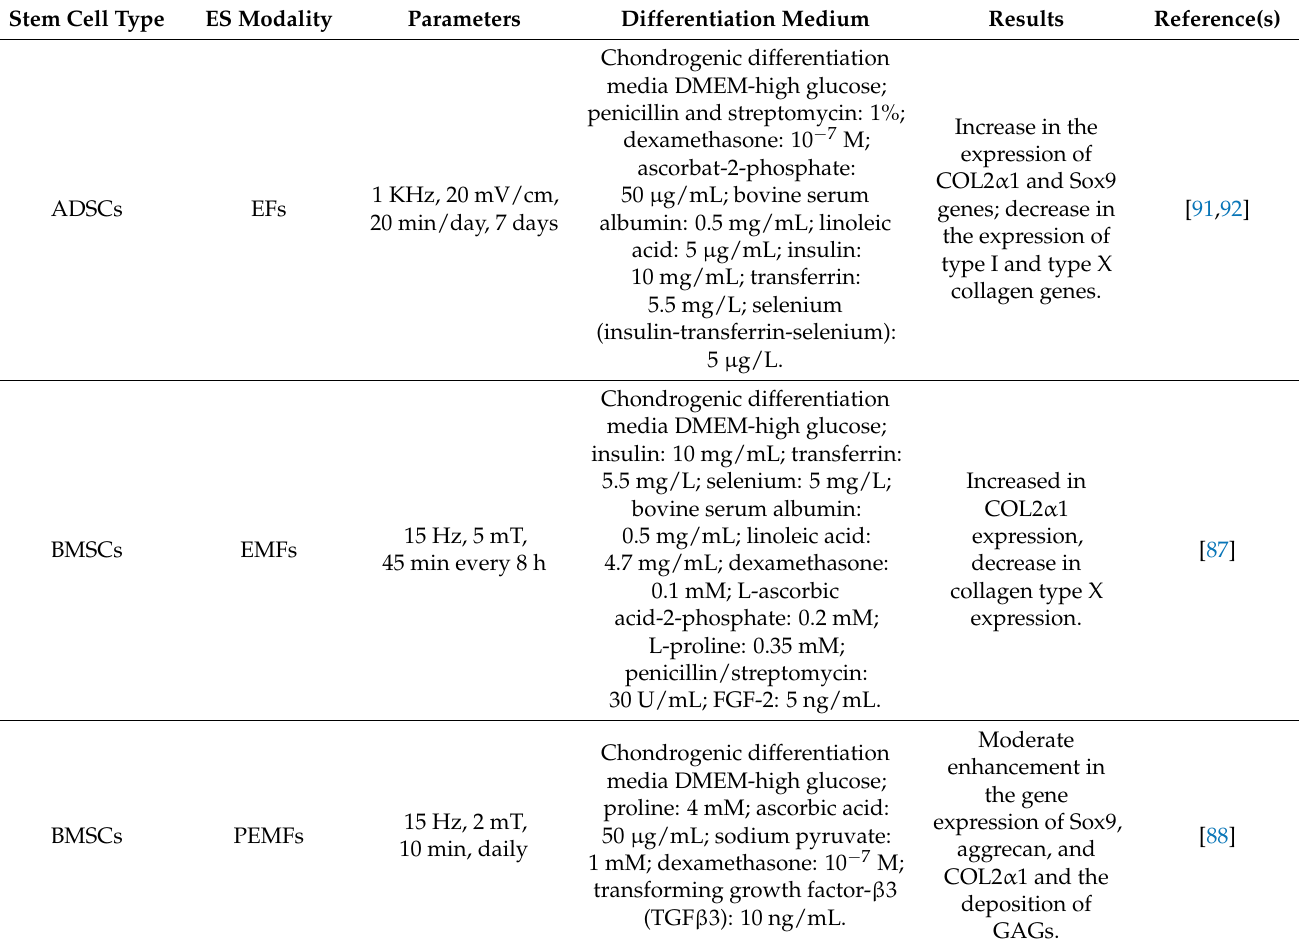
Table 2. ES induced stem cell differentiation towards chondrocytes in